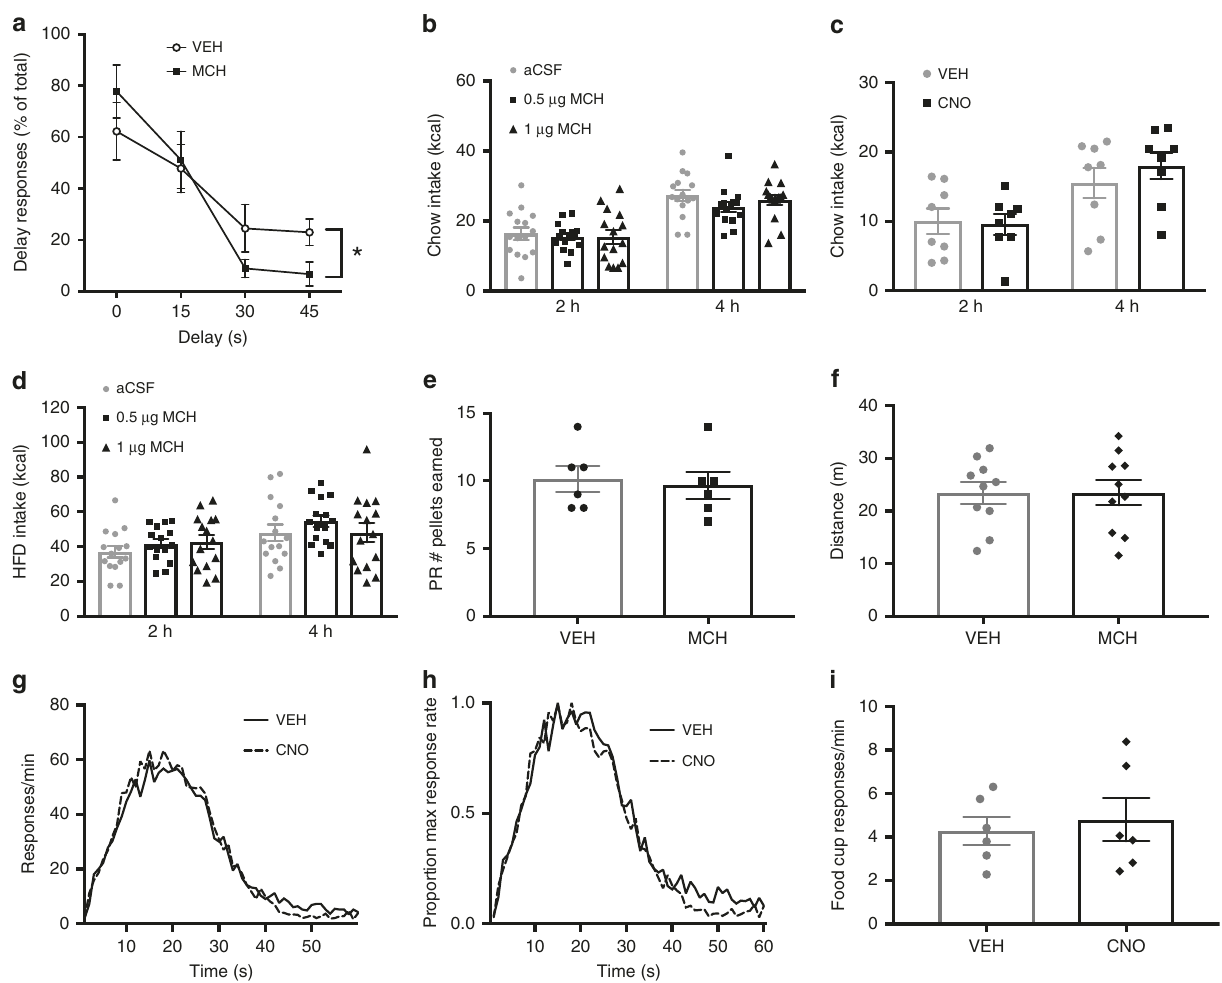
Fig. 4 vHP MCH signaling increases impulsive choice but not food motivation or timing accuracy. a MCH (1 µ g in the vHP) effects on performance in the delay discounting task (two-way repeated measures ANOVA with delay× drug treatment; n = 9). Results show a signi fi cant delay× drug interaction ( F (3,24) = 5.53; P = 0.005) , with main effect of delay time ( F (3,24) = 18.21; P <0.0001). ( b – d ; Two-way repeated measures ANOVA (time× drug)). b Effect of vHP MCH injection ( n = 15) and c chemogenetic activation of vHP projecting MCH neurons ( n = 8) on standard chow intake in the home cage. ( d Effect of vHP MCH injection on high fat/high sugar (HFD) diet intake ( n = 15). e MCH (1 µ g in the vHP) effect on the number of pellets earned in the progressive ratio task (Student ’ s two-tailed, paired t test; n = 6). f Effect of 1 µ g of MCH (0.5 µ g/side) in the vHP on distance traveled in the open fi eld test (Student ’ s two-tailed, paired t test; n = 10). g – i Effect of chemogenetic activation of MCH neurons on peak interval timing ( n = 6). g Peak interval response rates during probe trials, with increased response rates that peaks near the 20s criterion duration; h normalized function for peak rate, where the peak function for each animal was converted to a percentage of maximum response rate. This analysis revealed no horizontal shift in the peak interval timing function (two-way repeated measures ANOVA; F (1,5) = 1.63, 0.25) following activation of MCH neurons by lateral ventricle CNO injections. i MCH neuronal activation also had no in fl uence on food cup approach behavior during the peak interval test (Student ’ s two-tailed, paired t test). Data shown as mean ±SEM; (* P < 0.05). Source data are provided as a source data fi